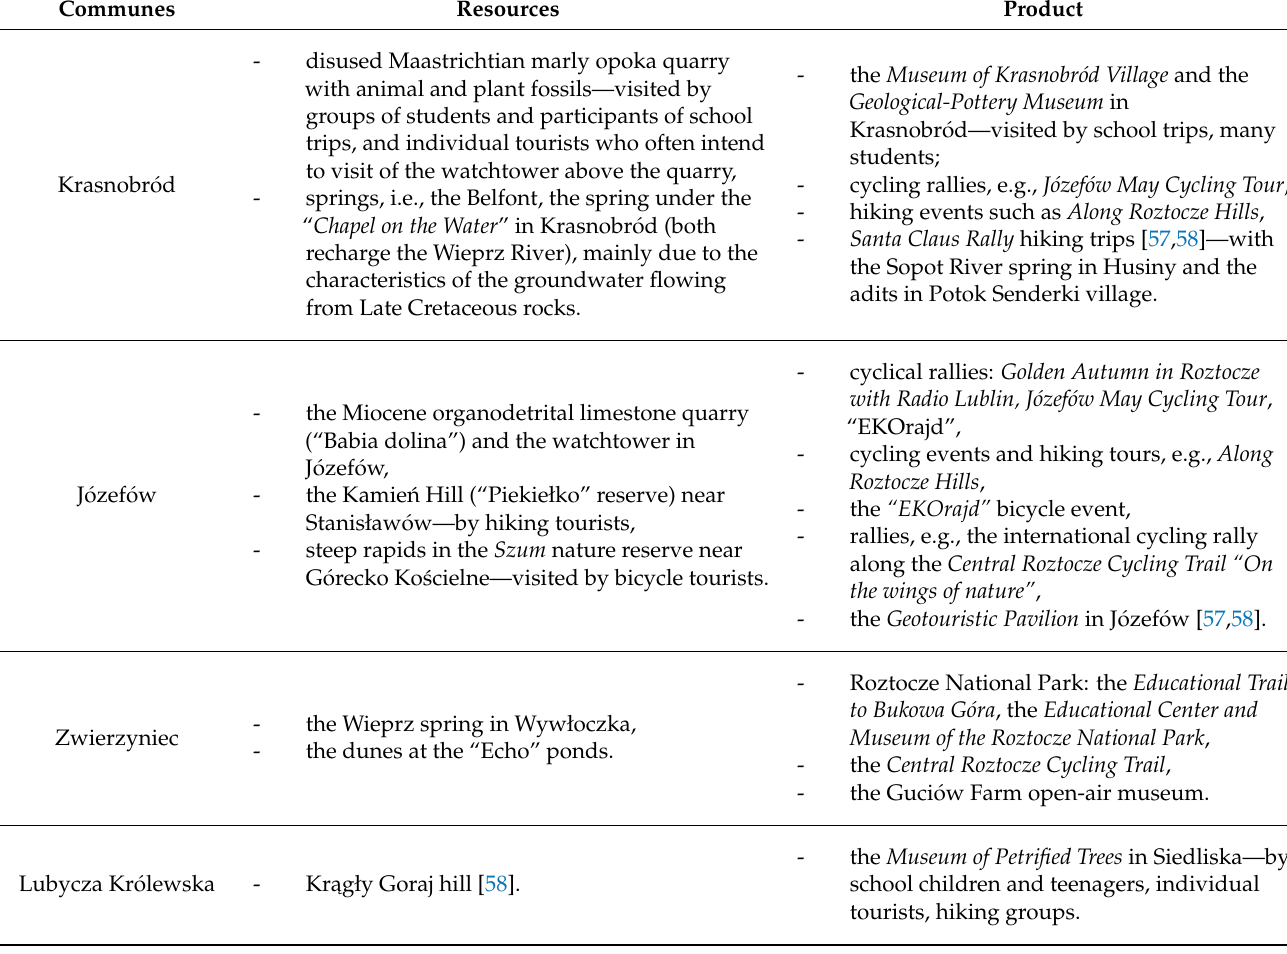
Table 12. Communes with a very well-developed (TGFI > 0.184) geotourism function. Communes